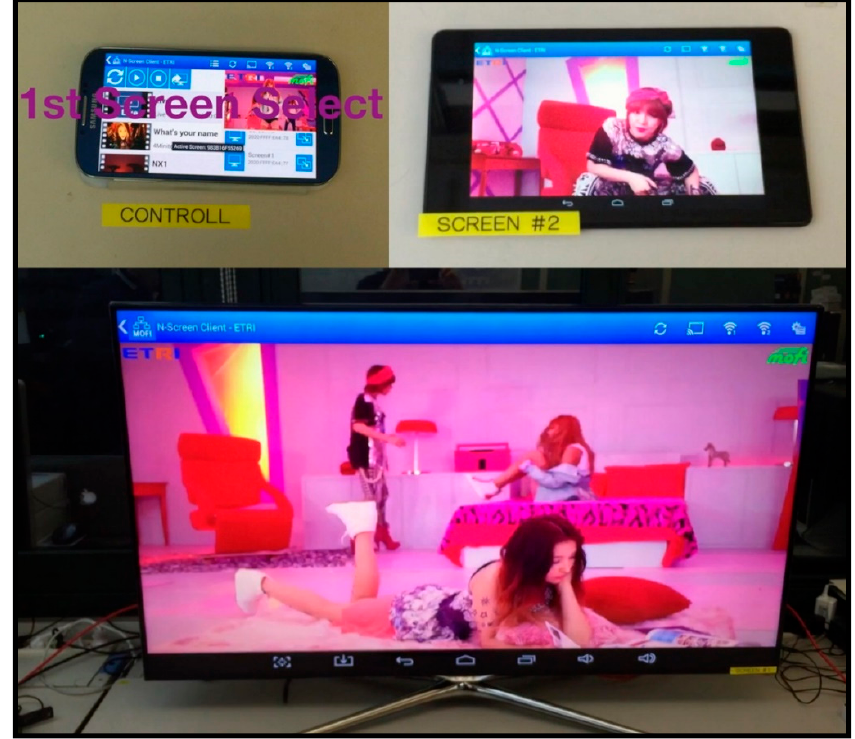
Figure 33. N ‐ Screen scenario. Figure 33. N-Screen